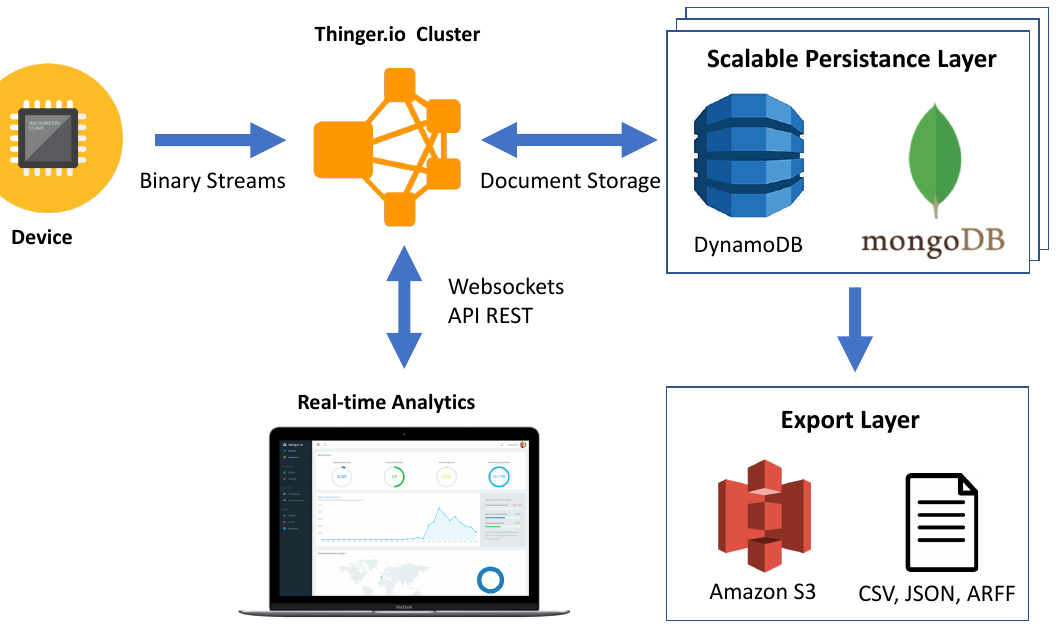
Figure 7. Thinger.io Big Data Storage